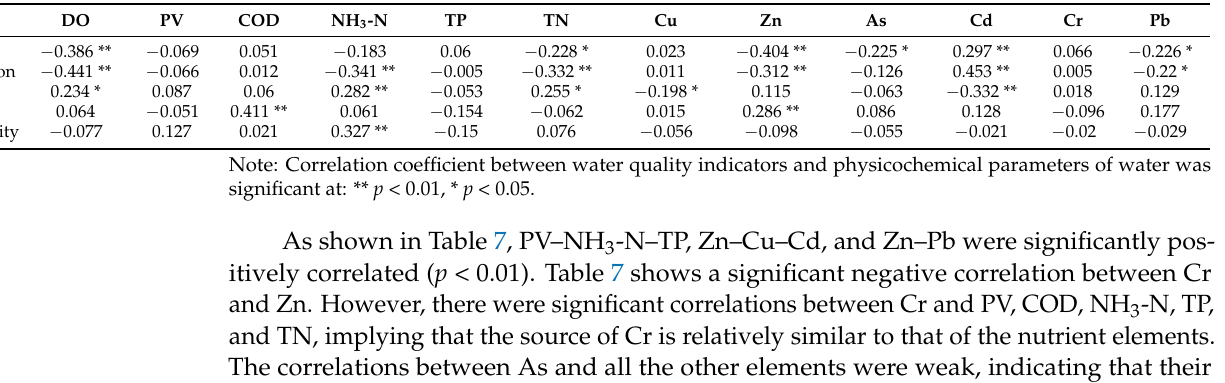
Table 6. Correlation between water quality indicators and physicochemical parameters of water.